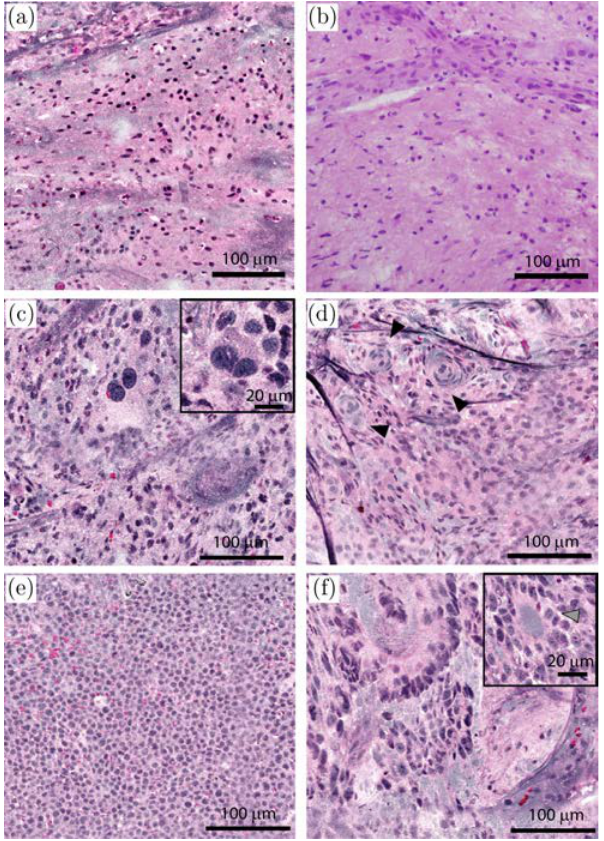
Fig. 8. SRH of human brain tumors with various subtypes: table, (b) H&E image of the same tissue type as (a). Repre- sentative SRH images of (c) high-grade glioma, (d) meningioma, (e) lymphoma and (f)